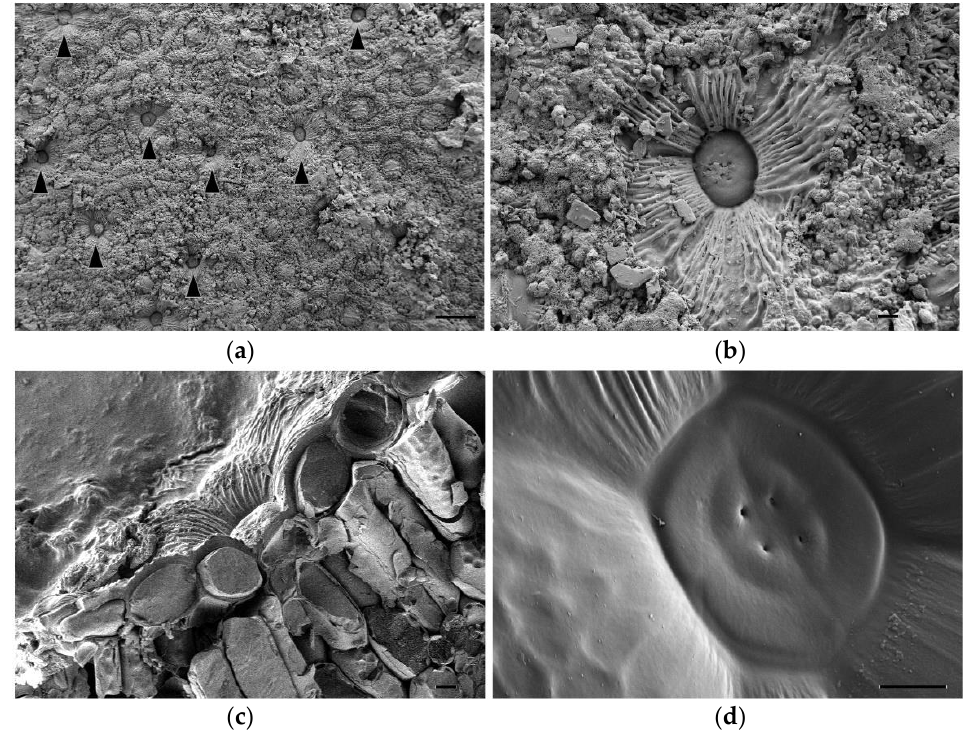
Figure 3. Cryo-FESEM images of salt glands of Limonium angustebracteaum grown under control conditions. ( a ) Salt glands (indicated by black arrowheads) located on the leaf epidermis. ( b ) Close look up of a salt gland on the leaf epidermis. Notice salt crystals’ excretion. ( c ) Transversal section of a salt gland located on leaf epidermis pits. ( d ) Detailed image of the salt gland core. Only two rings of salt gland cells are easily noticeable on this SEM image: 4 secretory cells in the centre, each of them with a secreting pore; 4 accessory cells surrounding the inner ring of secretory cells; just beneath it, a border of another accessory cell (bottom left) can be observed. Scale bar: 100 μm ( a ), or 10 μm ( b – d ).